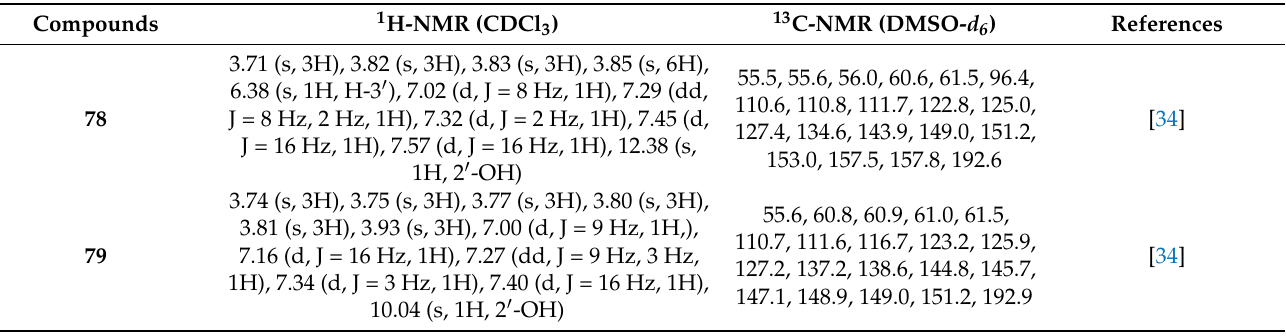
Table 15. 1 H-NMR and 13 C-NMR data of isolated polymethoxychalcones ( 78 – 79 ) in Citrus genus. Compounds